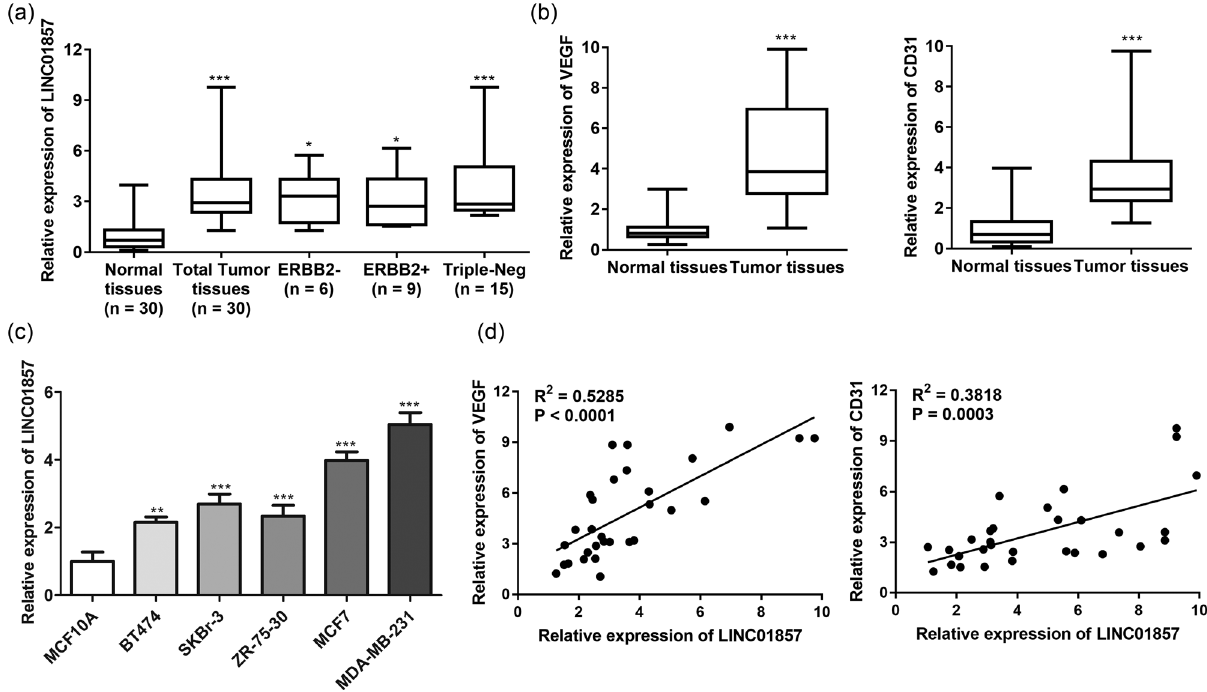
Figure 1: LINC01857 levels are increased in BC tissues and cells: ( a ) expression of LINC01857 in total tumor tissues, and the three isoforms ( ERBB2 − , ERBB2 + , and Triple - Neg ) were determined by qRT - PCR; ( b ) VEGF and CD31 levels in BC tissues and ( c ) cells were detected by qRT - PCR assay; ( d ) the correlation of VEGF or CD31 with LINC01857 was analyzed by correlation analysis. ** P < 0.01 and *** P < 0.001 vs normal tissues or MCF10A